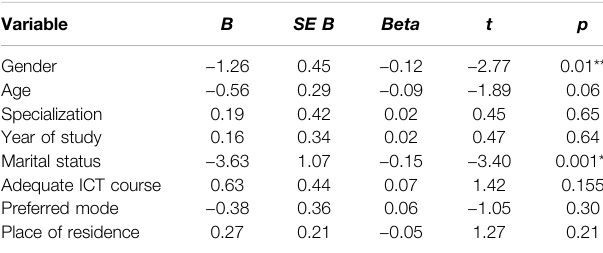
TABLE 5 | Summary of demographic variables predicting dependent learning.